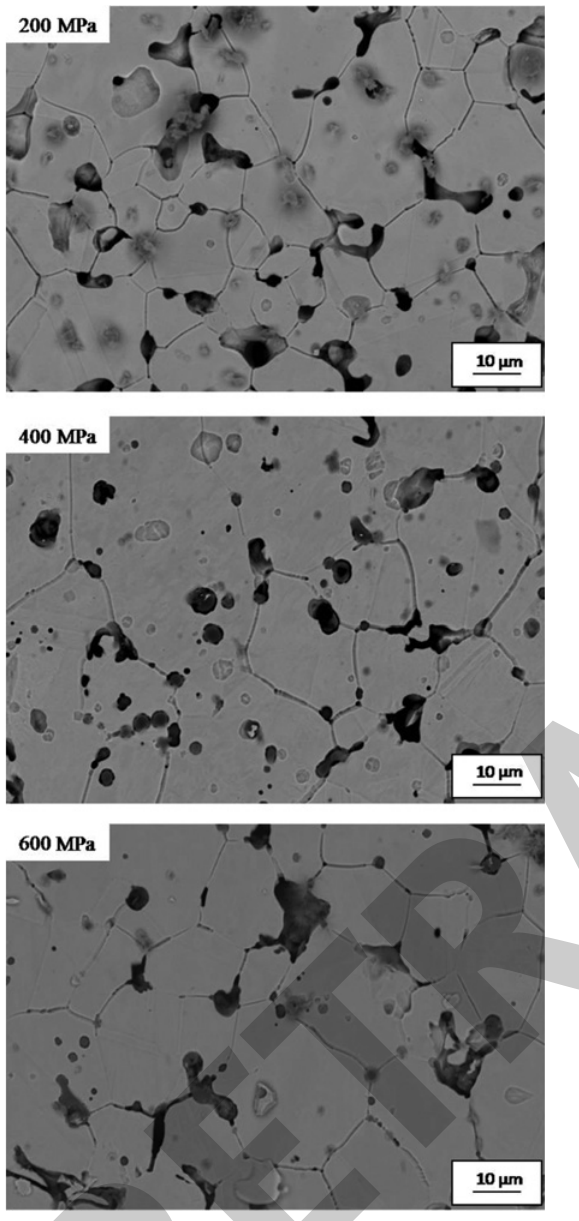
Figure 7: SEM micrographs of corroded 316L samples compacted at different pressures ( 200, 400 and 600 MPa) and sintered at 1,400°C.